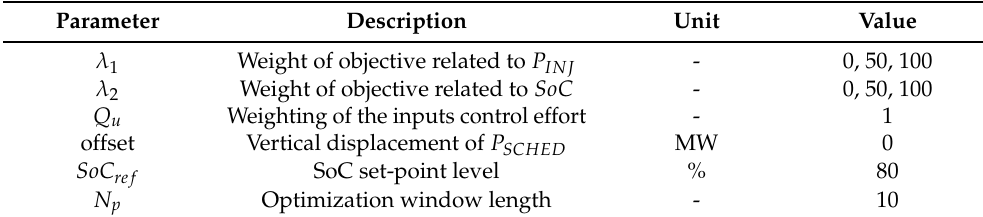
Table 3. Optimization parameters values.